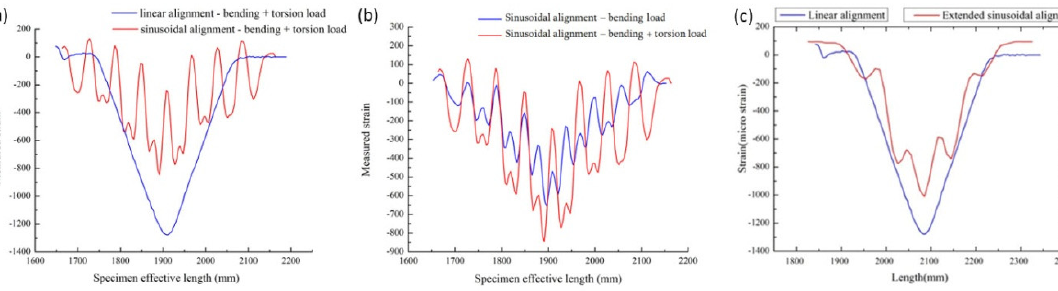
Figure 6. Fiber-optic sensor (FOS) installation method for a reference surface area [139].